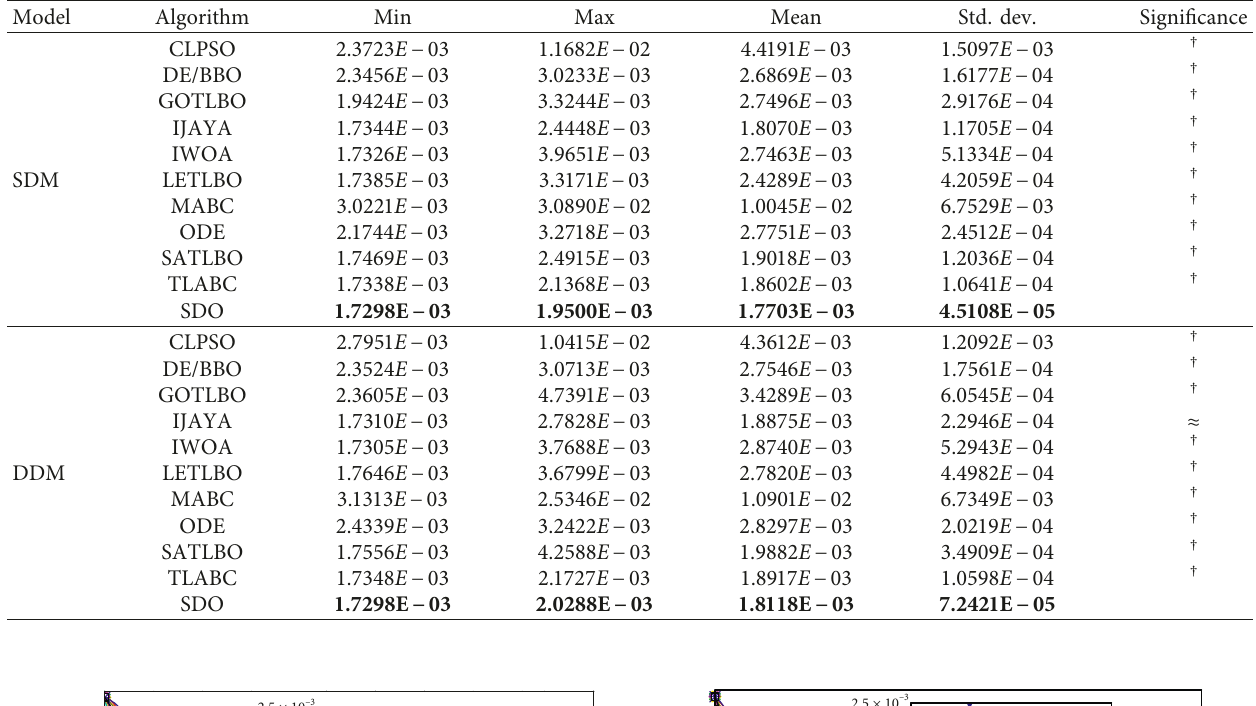
Table 9: Experimental results on the STM6-40/36 module.